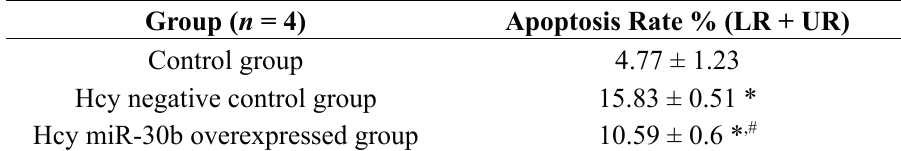
Figure 5. AnnexinV/PI flow cytometry apoptosis chart, on behalf of the control group ( A ); Hcy negative control group ( B ); and Hcy miR-30b overexpressed group ( C ). The concentration of Hcy was 1 mmol/L, both the time of transfection and treatment of Hcy were 24 h ( n = 4 in each group). Table 2. A poptosis rate of Hcy-induced in HCAECs.